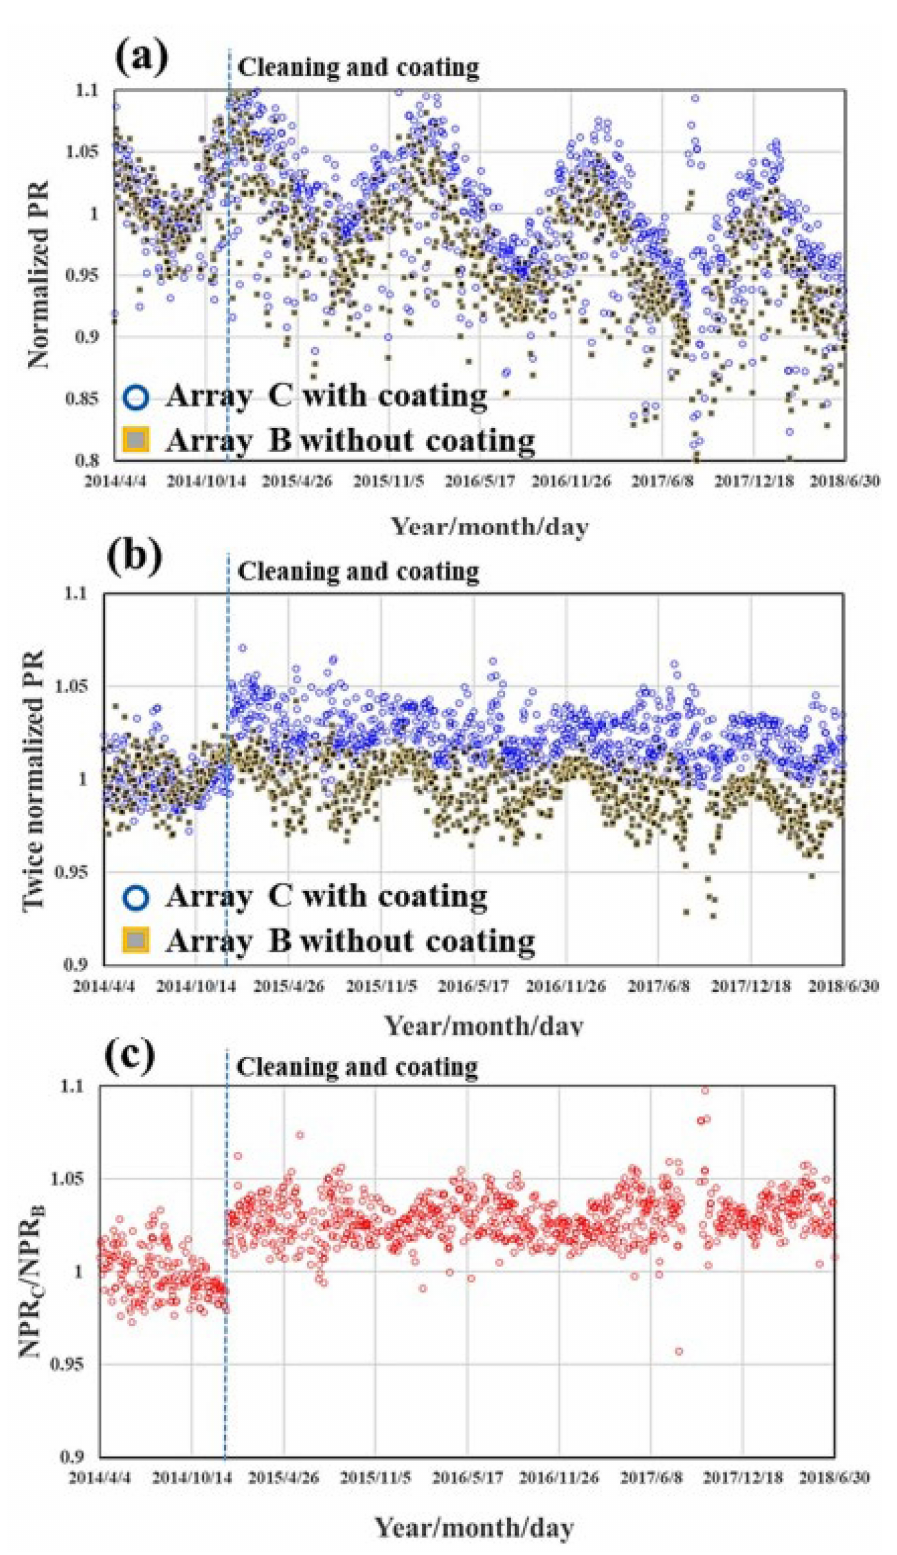
Figure 10. ( a ) Normalized daily performance ratio (PR) of arrays B (NPRB) and C (NPRC), ( b ) twice normalized daily PR of arrays B and C (NPRB and NPRC were divided by the normalized daily PR of reference array A), and ( c ) NPRC/NPRB